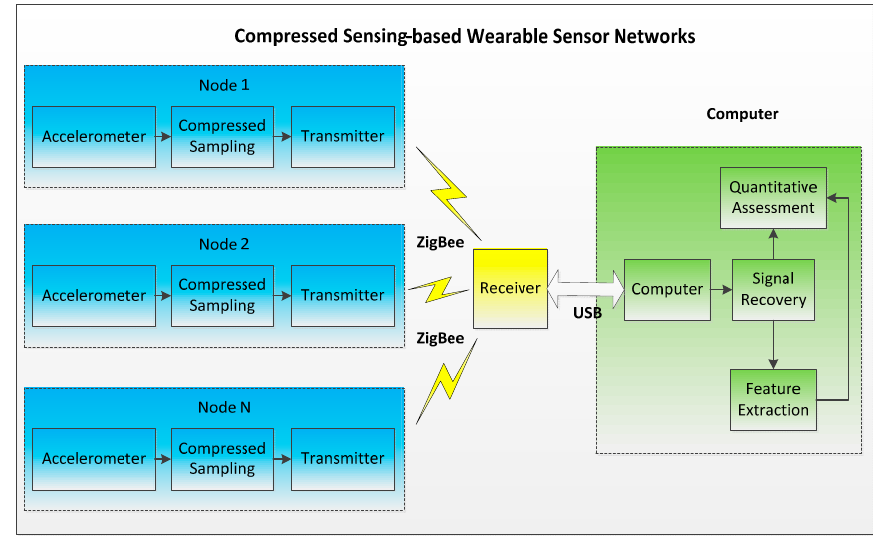
Figure 1. System structure of a compressed sensing-based wearable sensor network.